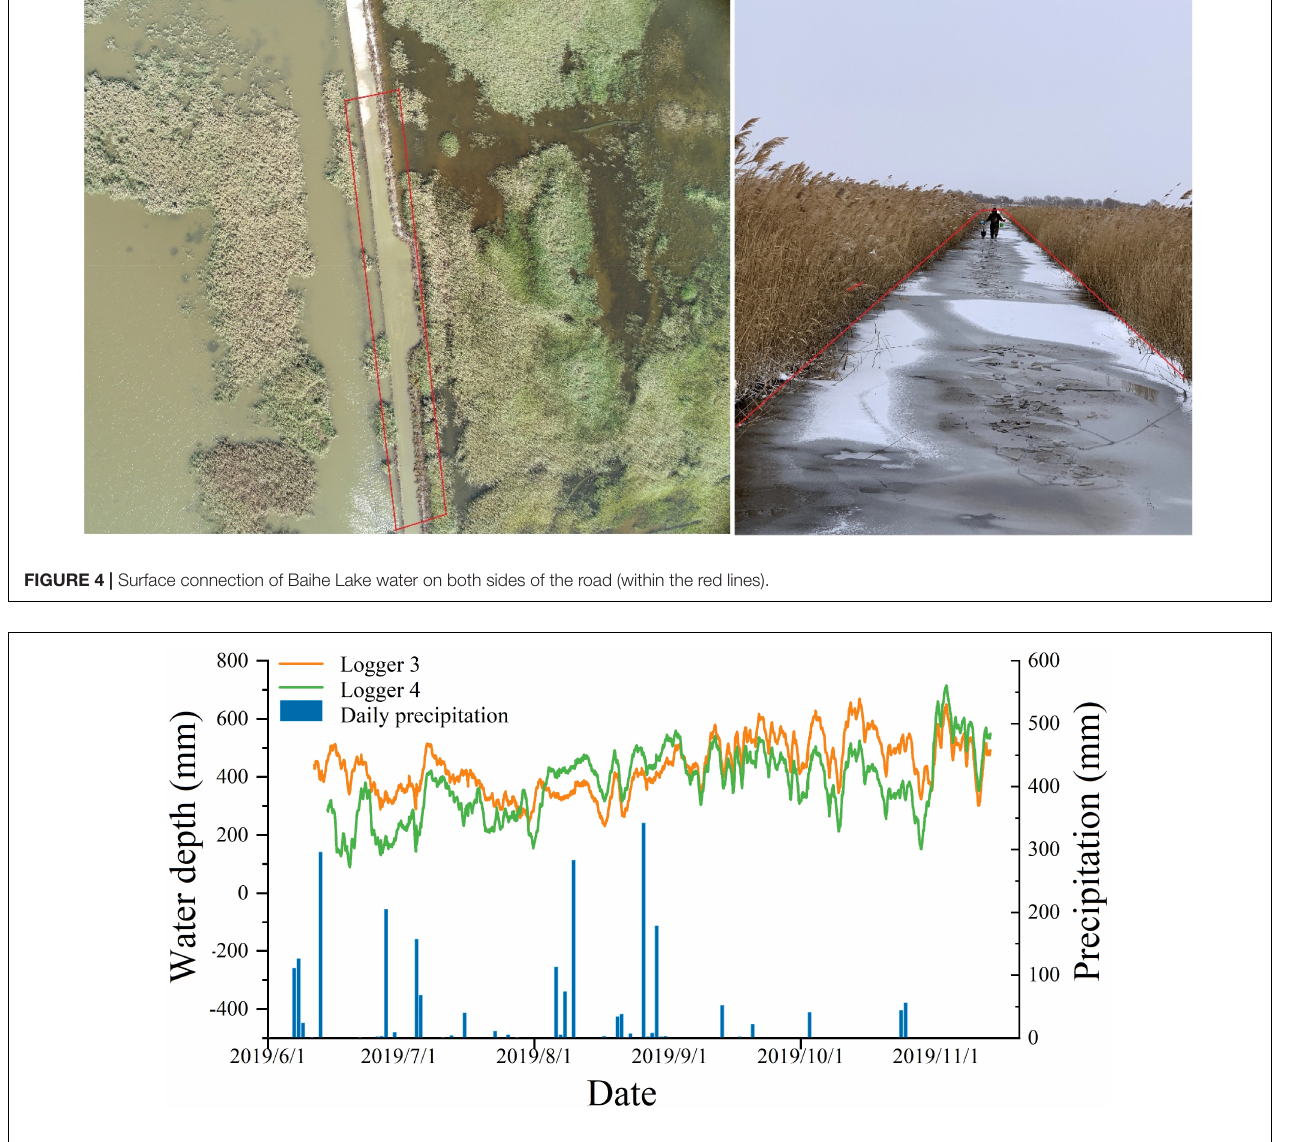
FIGURE 5 | Surface water level fluctuations affected by